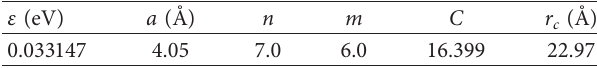
Table 1: The main parameters of amorphous